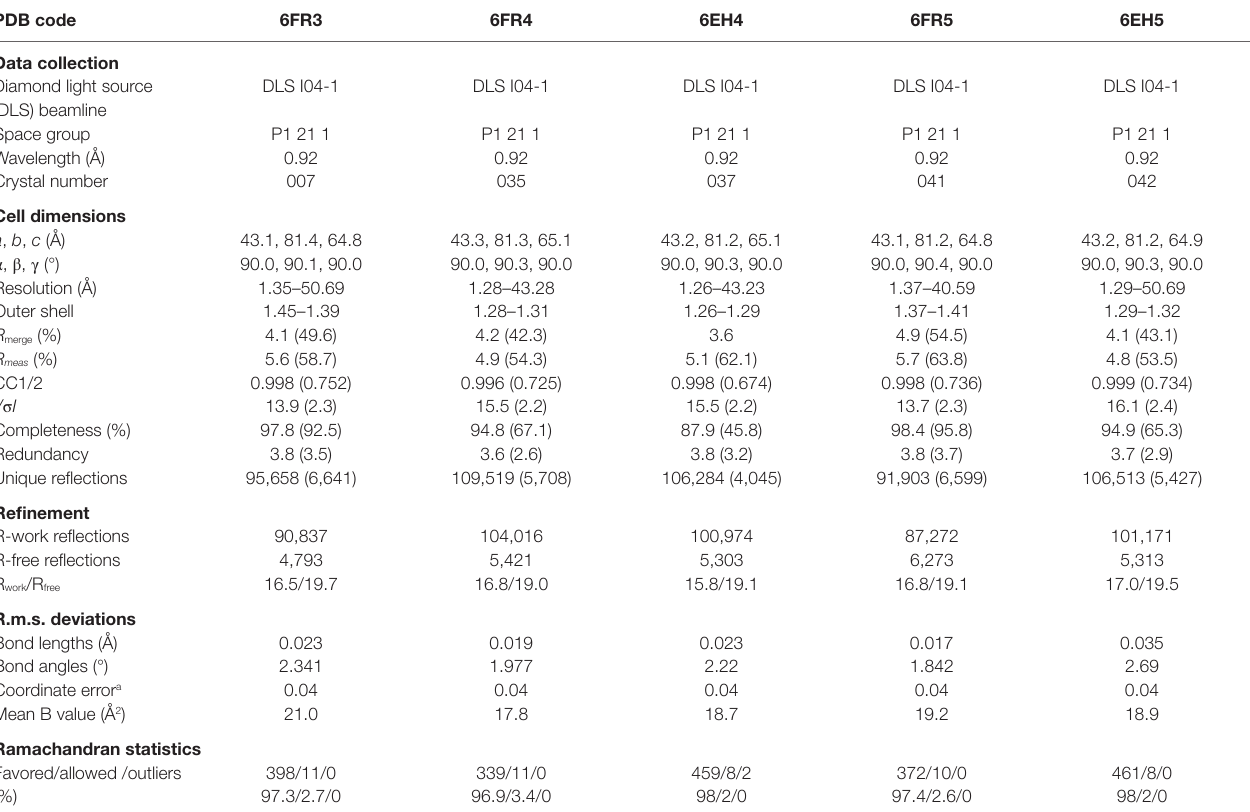
Table 4 | Data collection and refinement statistics for 003 T cell receptor structures.